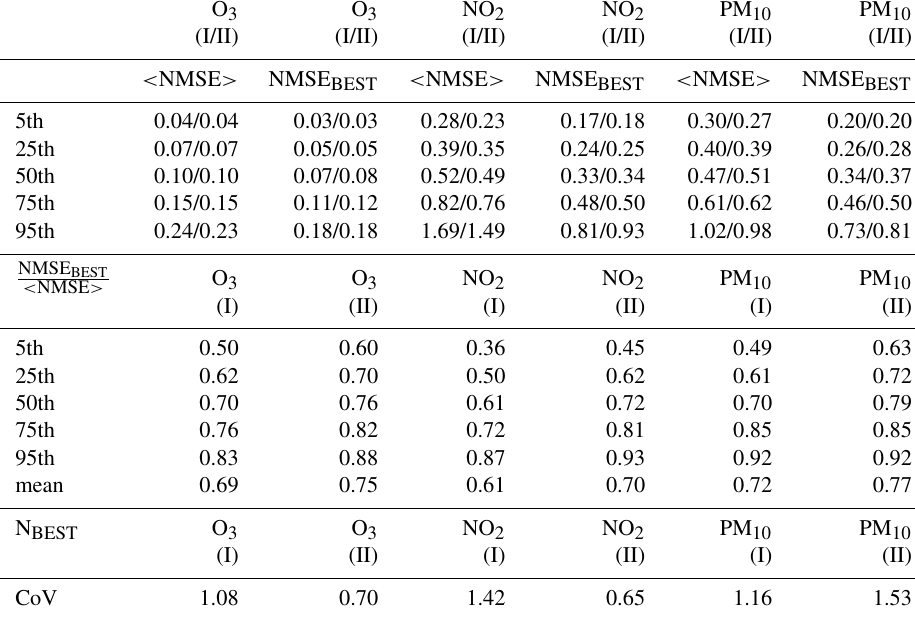
Table 2. The statistical distribution of (a) the normalized mean square error (NMSE) of the best model (NMSE BEST ), (b) the ensem- ble average NMSE ( < NMSE > ) and (c) the skill difference indicator (NMSE BEST / < NMSE > ). In addition, the coefficient of variation (CoV = standard deviation divided by the mean) of the number of cases where each model was identified as best is shown. All indicators were evaluated at each monitoring site for the examined species of the two AQMEII